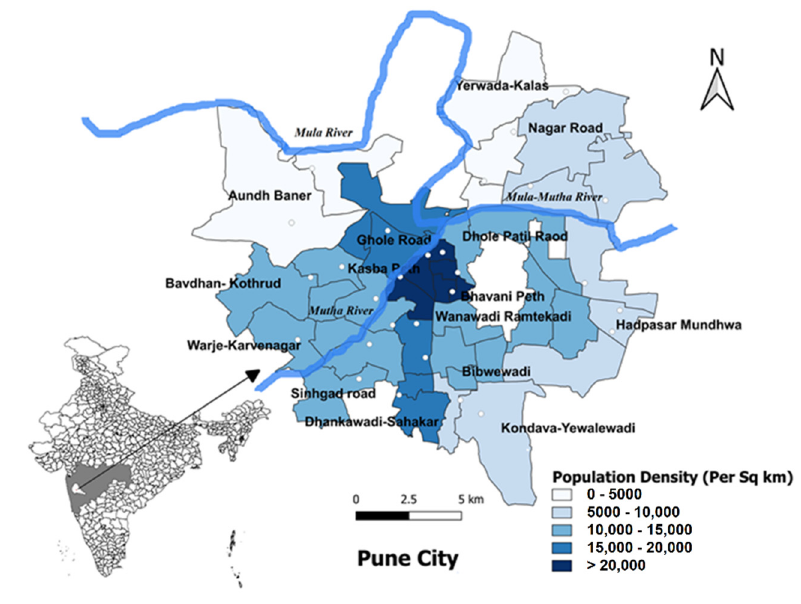
Figure 1. Georeference map of locations of 30 clusters surveyed in 15 administrative zones in Pune City, 2019. The administrative zones ( n = 15) are highlighted in different shades of blue with the actual georeferenced locations of 30 clusters selected by using the probability-proportional-to-size (PPS) sampling. They are located on the map of Pune Municipal Corporation (PMC), Pune City for the second survey undertaken in 2019. The map also shows the Mula-Mutha river flowing through Pune City.